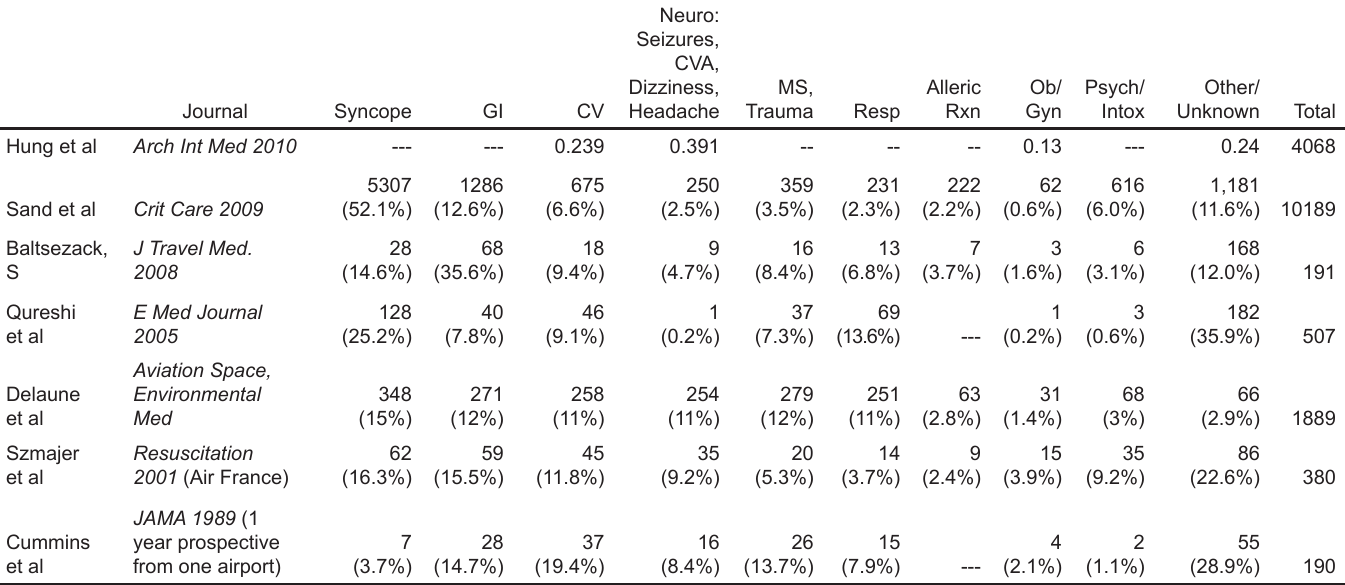
Table 2. In-flight emergencies by